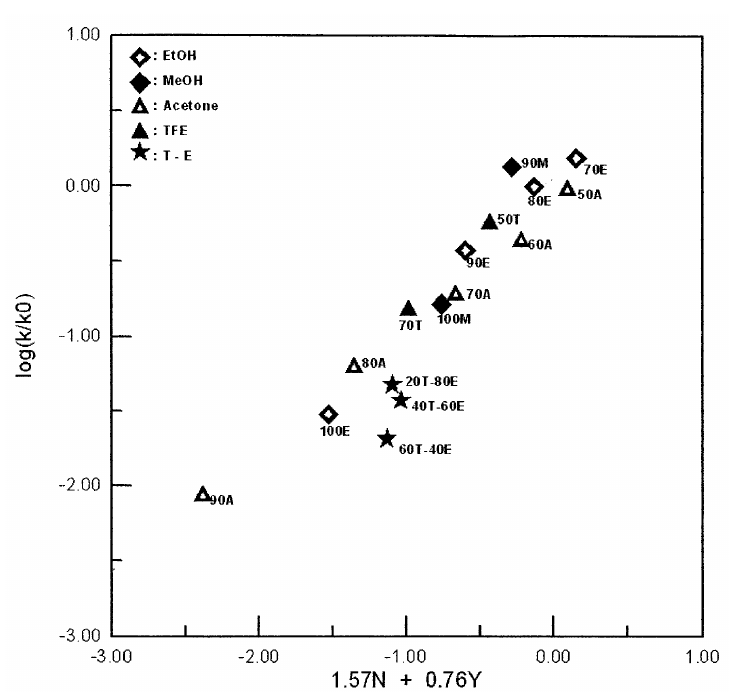
) vs. (1.57N + 0.76Y ) for the solvolyses of benzyl fluoroformate in 0 T Cl indicated.